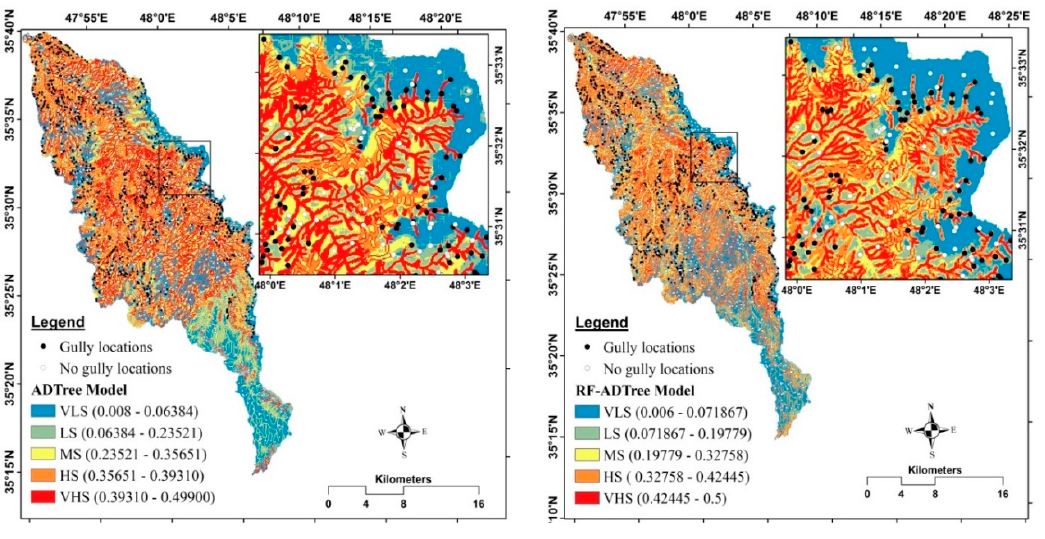
Figure 7. Gully erosion maps obtained by RF-ADTree model and other soft computing benchmark